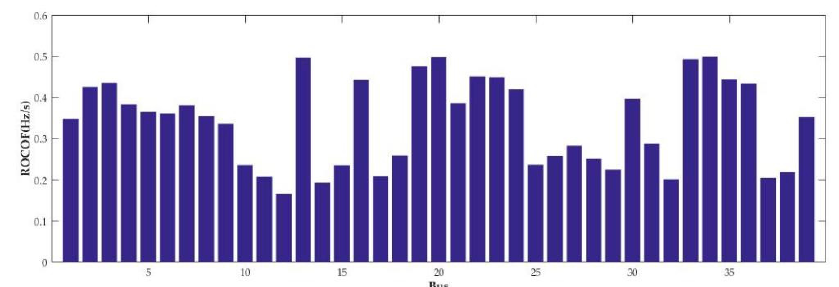
Figure 7. Rate of change in frequency of each node.